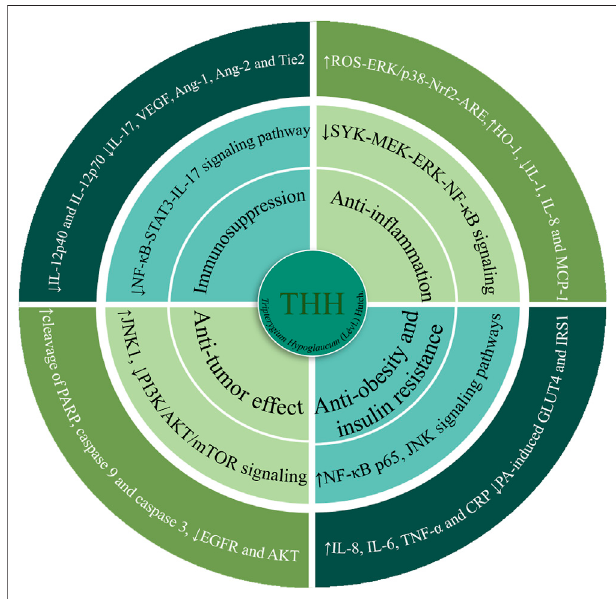
FIGURE 4 | The main signalling pathways and molecular targets of the pharmacologically active components in